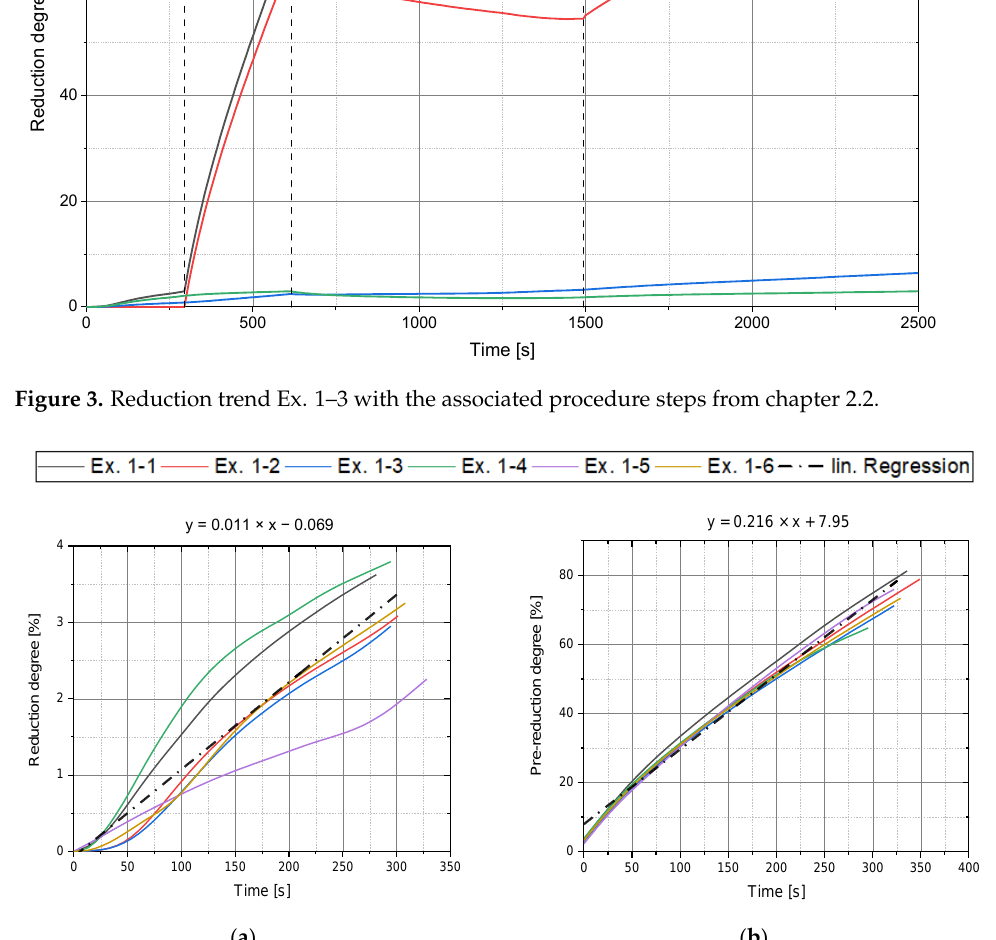
Figure 4. Pre-melting ( a ) and pre-reduction trend ( b ) Ex.1 – 1 to Ex. 1 – 6.